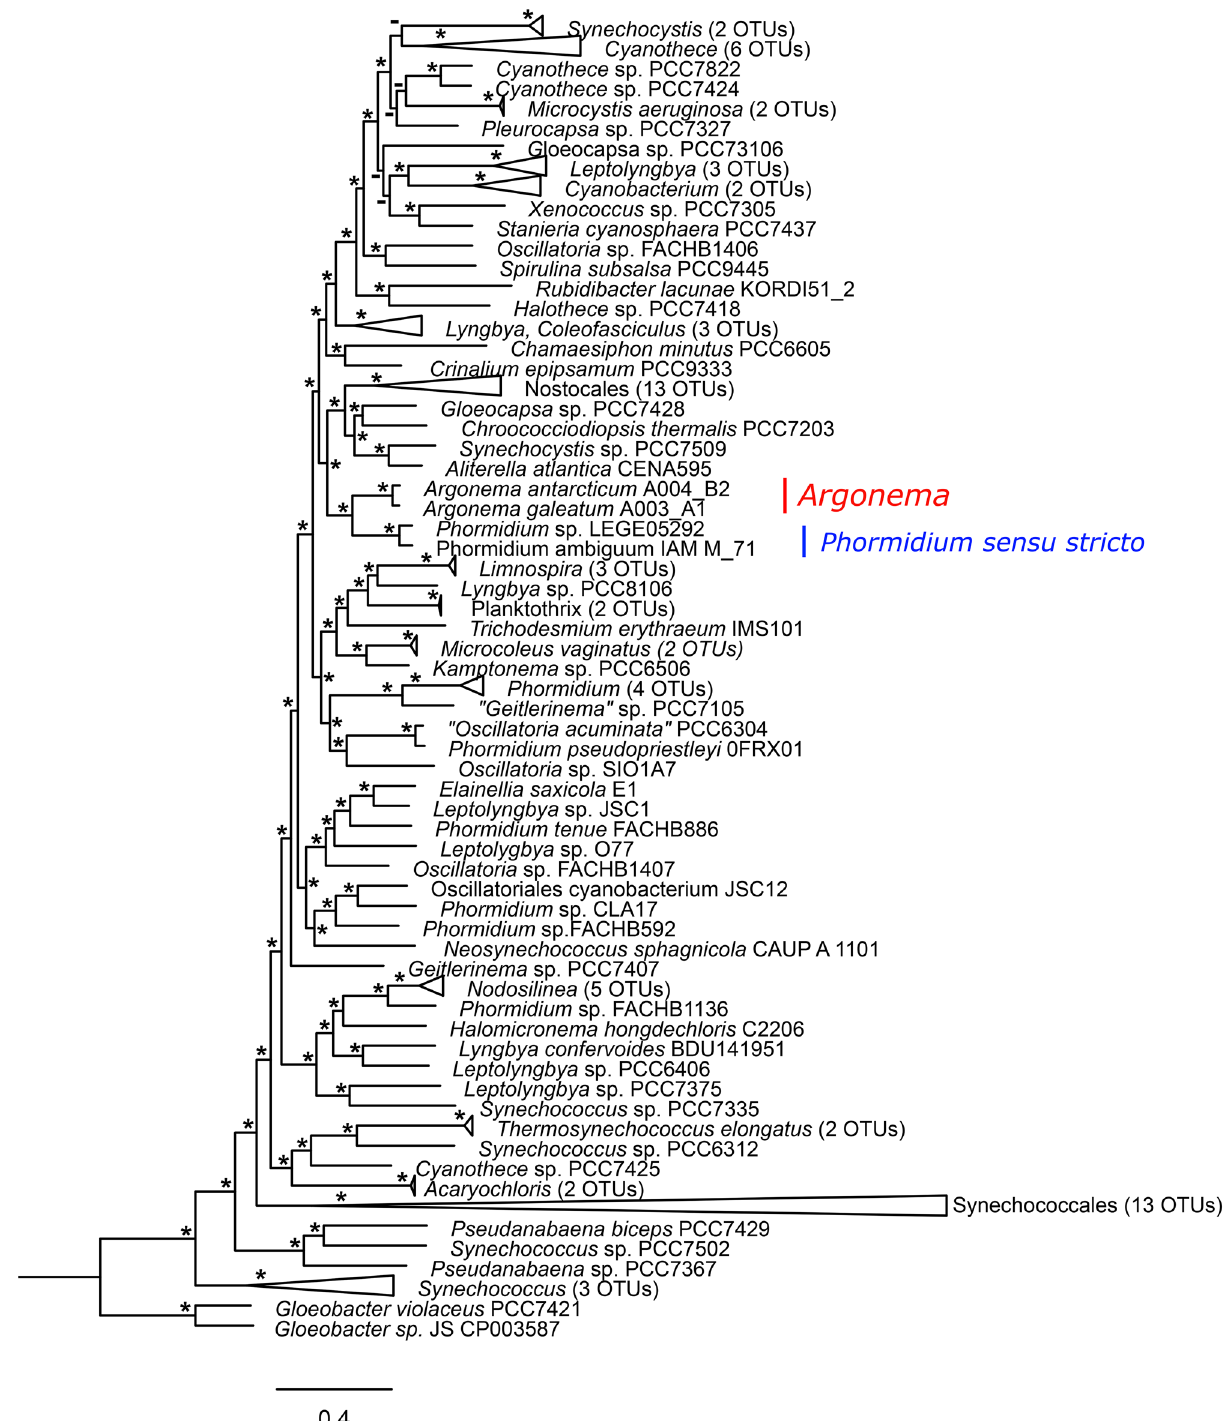
Figure 13. Maximum likelihood phylogenomic reconstruction of cyanobacteria based on 153 585 amino acid sites. Nodes with bootstrap support of 99 or 100 are marked with an